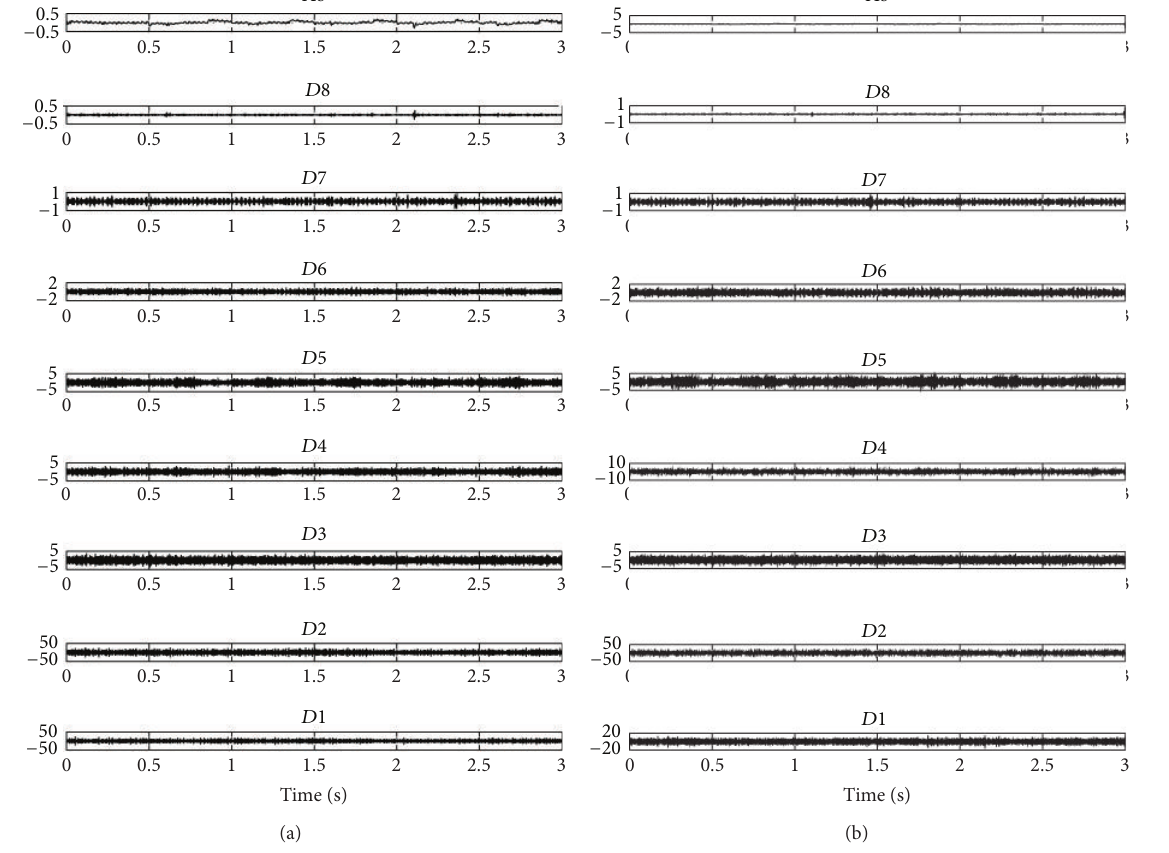
Figure 5: Wavelet Transforms. (a) Condition 1; (b) condition